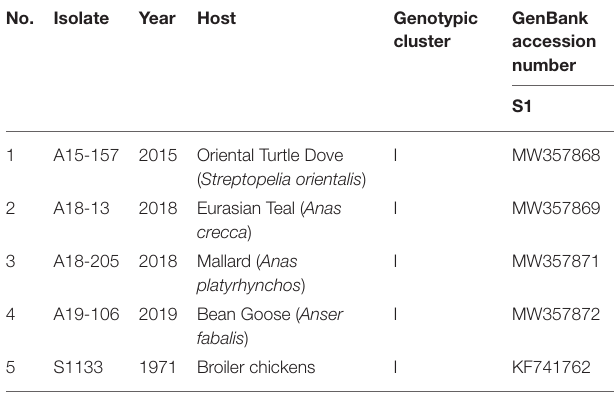
TABLE 1 | Isolates of ARV originating from wild birds and a vaccine used in the present